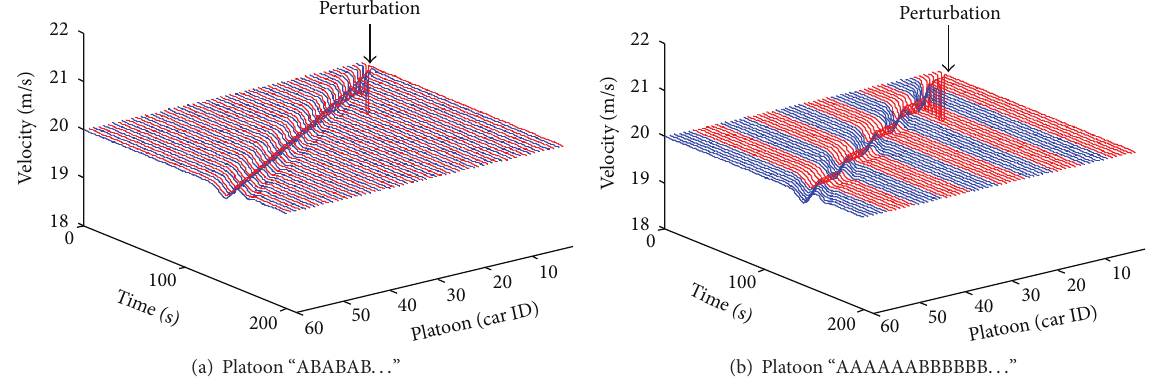
Figure 5: Propagation of perturbation along two types of binary platoon (color